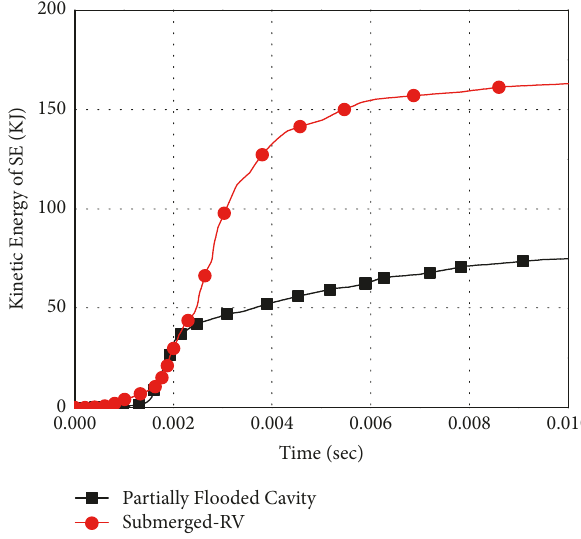
Figure 15: Kinetic energy calculated from the impulse of steam explosion at the bottom of the water tank in both